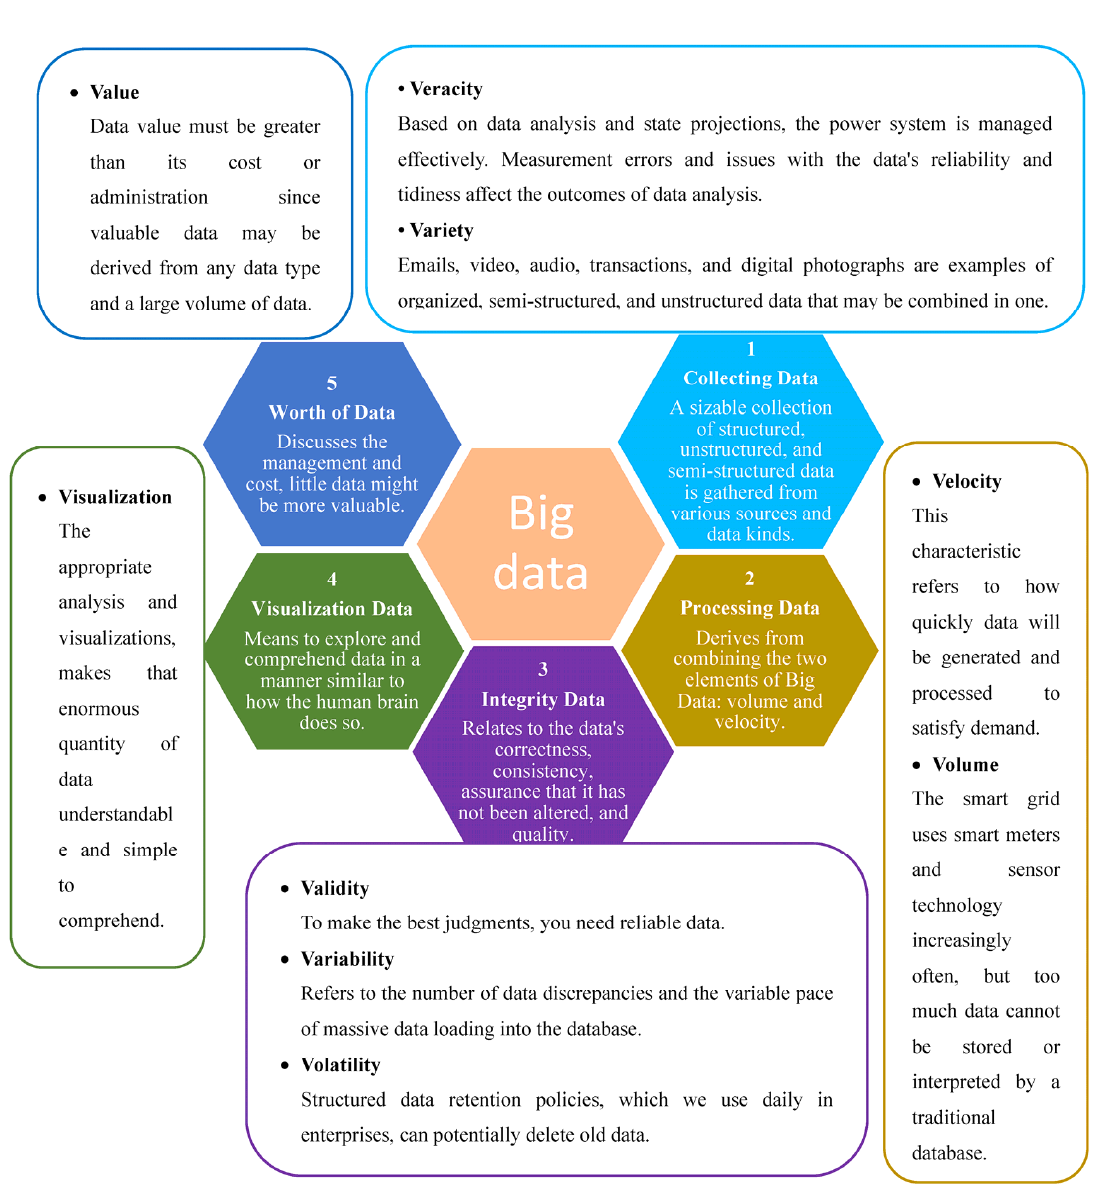
Figure 2. Five categories (collecting data, processing data, integrity data, visualization data, and worth of data) of big data with their 9 Vs characteristics.